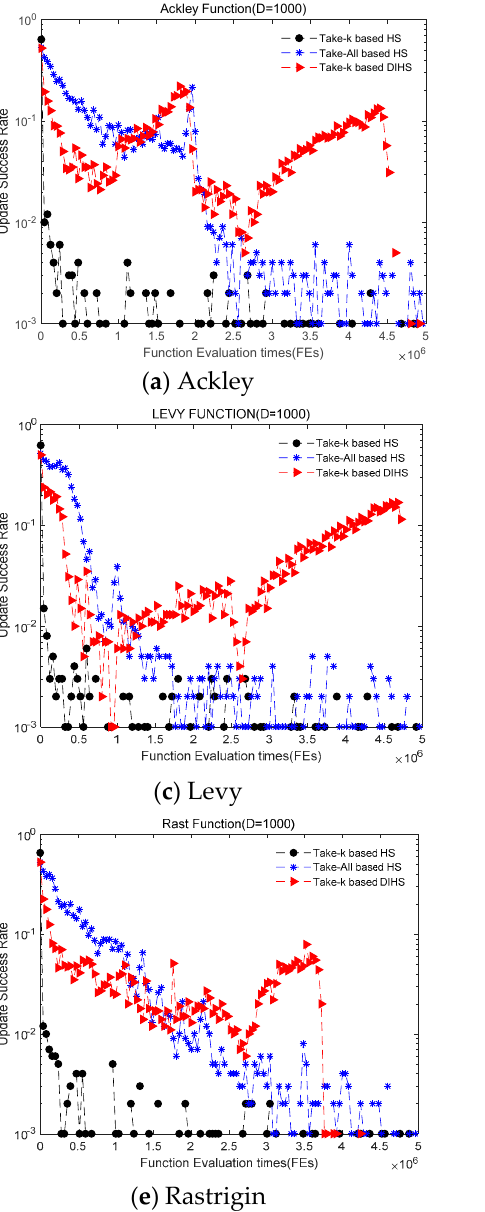
Figure 4. Update success rate comparisons of the take-all and take-k strategies.